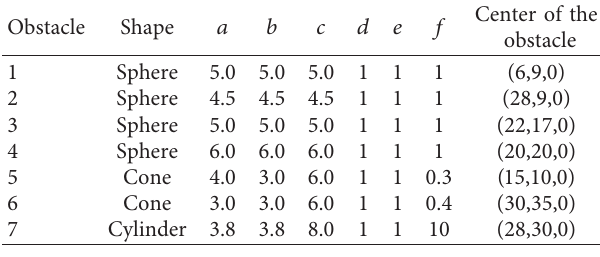
Table 1: The shape parameters of each obstacle. Obstacle Shape